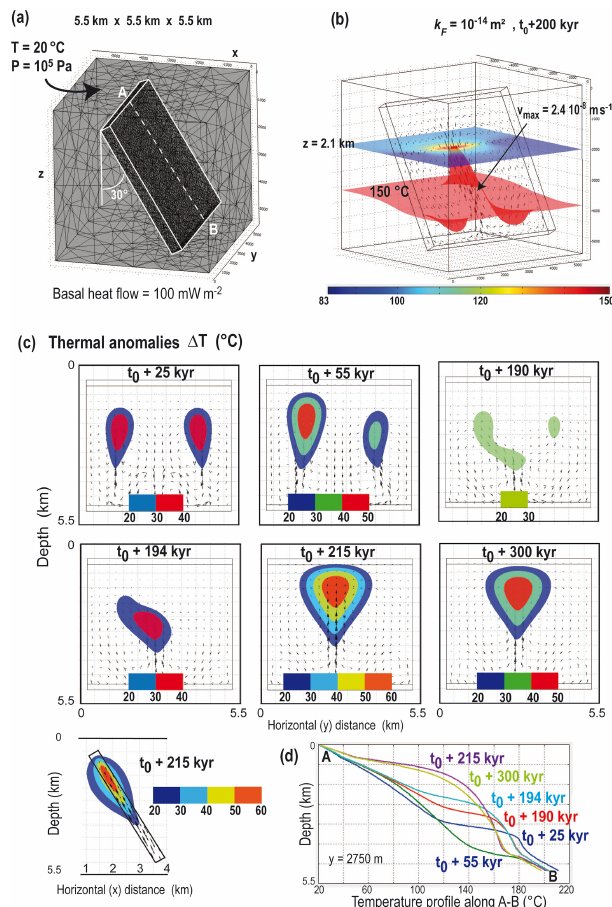
Figure 9. (a) Similar experiment as in Fig. 8 but for an inclined (30 ◦ ) fault zone. (b) A temperature of 150 ◦ C is reached at a depth of 2.1km. The color bar corresponds to temperature values at a depth of 2.1km; (c) temporal evolution of thermal anomalies (col- ored zones) viewed in a vertical plane: a similar transition from two upwellings to a single central one is observed. The perpendicular view at bottom left illustrates the lateral diffusion of the anomaly within the host rock. (d) Temperature evolution within the fault zone along the A–B